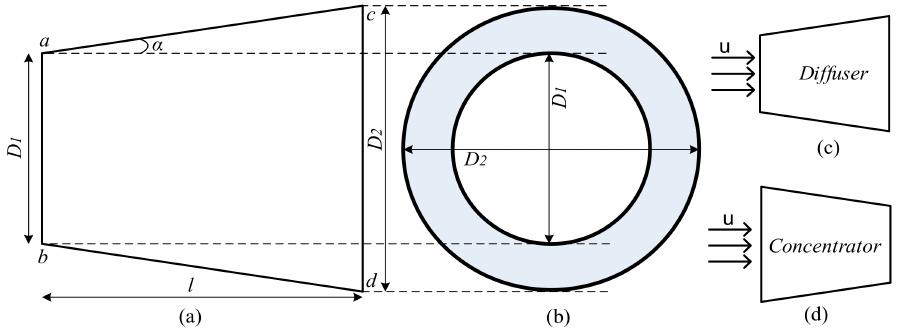
Figure 2. ( a , b ) Conical section dimensions; ( c ) diffuser mode; ( d ) concentrator